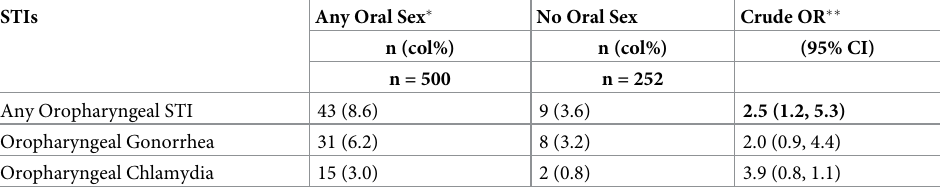
Table 3. Association of oral sex and bacterial oropharyngeal STIs among MSM and TGW in Nigeria. STIs Any Oral Sex � No Oral Sex Crude OR �� n (col%) n (col%) (95% CI) n = 500 n = 252 Any Oropharyngeal STI 43 (8.6) 9 (3.6) 2.5 (1.2, 5.3) Oropharyngeal Gonorrhea 31